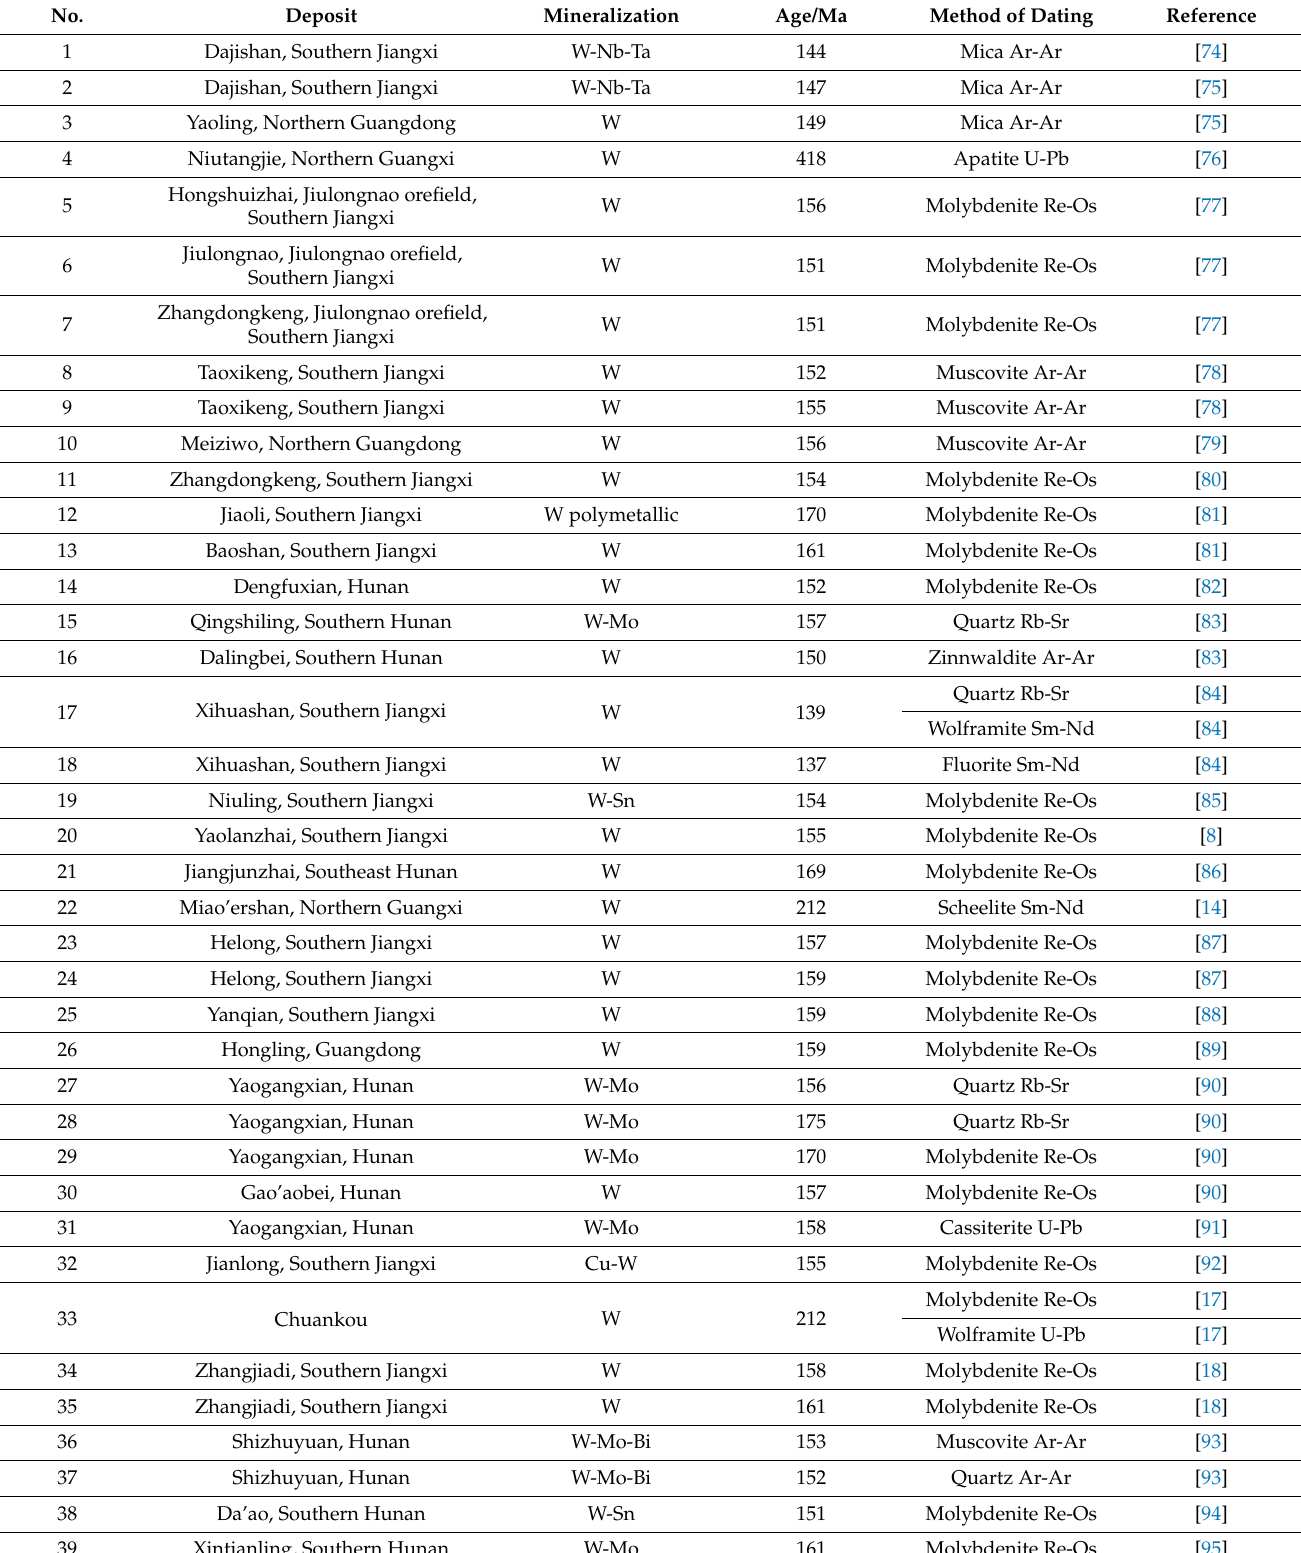
Table 4. Summary of chronological data on the major typical W polymetallic deposits in the Nan- ling